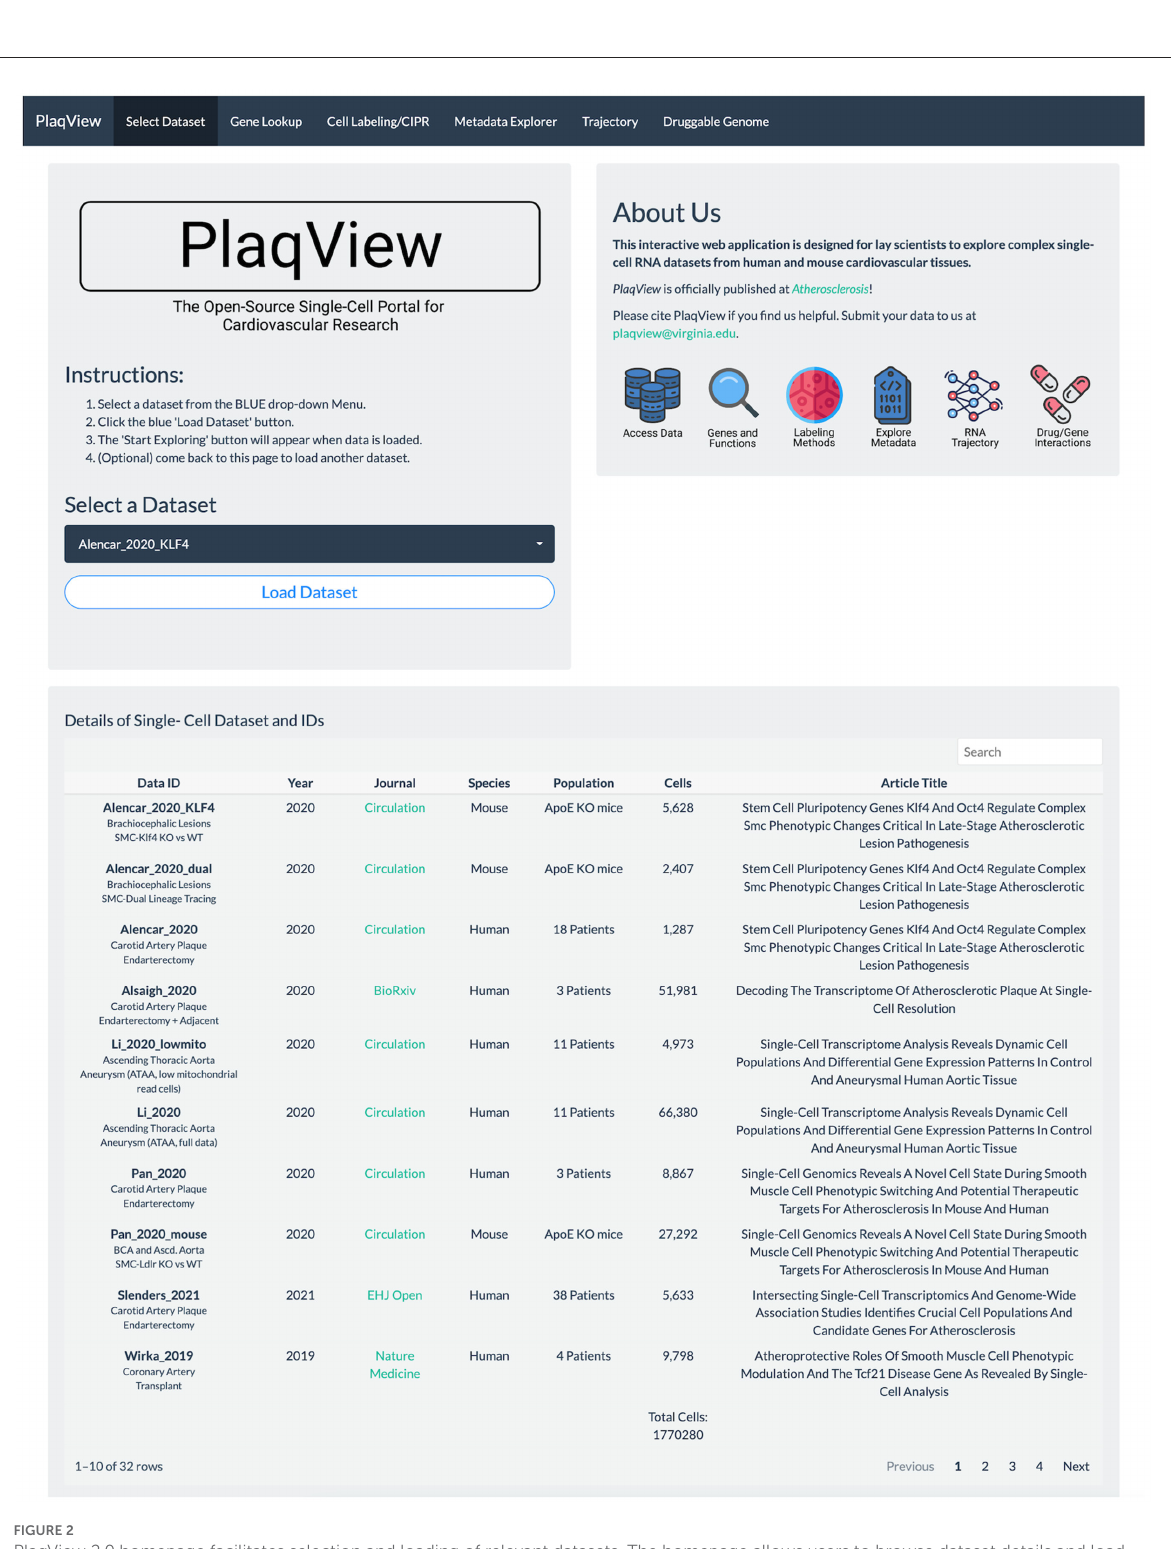
FIGURE2 PlaqView 2.0 homepage facilitates selection and loading of relevant datasets. The homepage allows users to browse dataset details and load selected datasets into their dedicated session for further